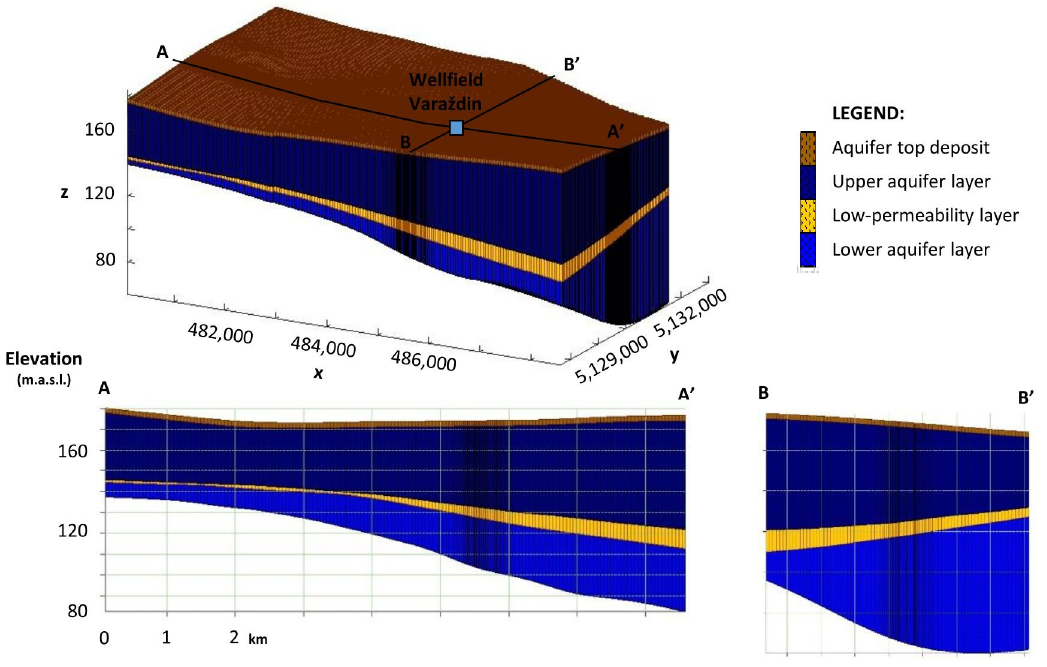
Figure 2. The 3D model of the study area with the representative hydrogeological cross-sections.